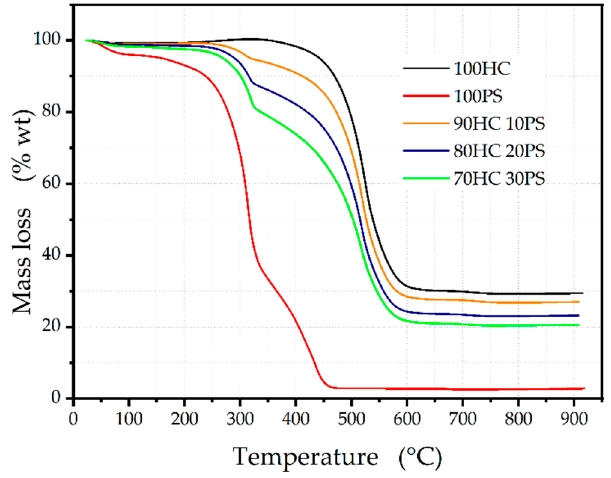
Figure 3. TG curves for all fuel samples at 5 °C/min heating rate under an air atmosphere.